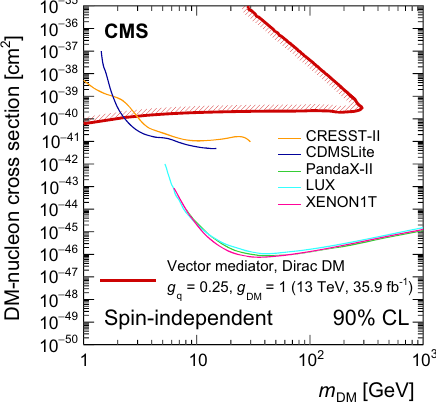
Fig. 7 Observed 90% CL limits on the DM-nucleon scattering cross sections in both spin-independent (left) and spin-dependent (right) cases, assuming a mediator-quark coupling constant g q = 0 . 25